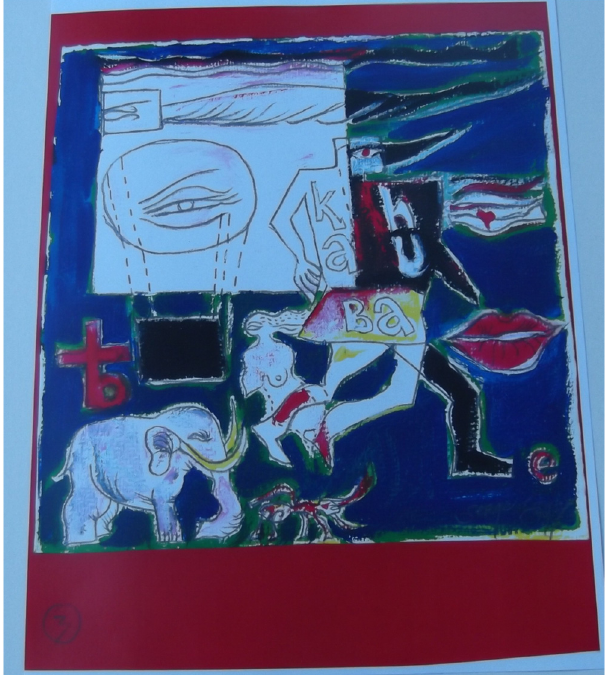
Figure 1. Illustration to Khlebnikov’s ‘Ka’ (2012). All figures in this manuscript have copyright permissions.